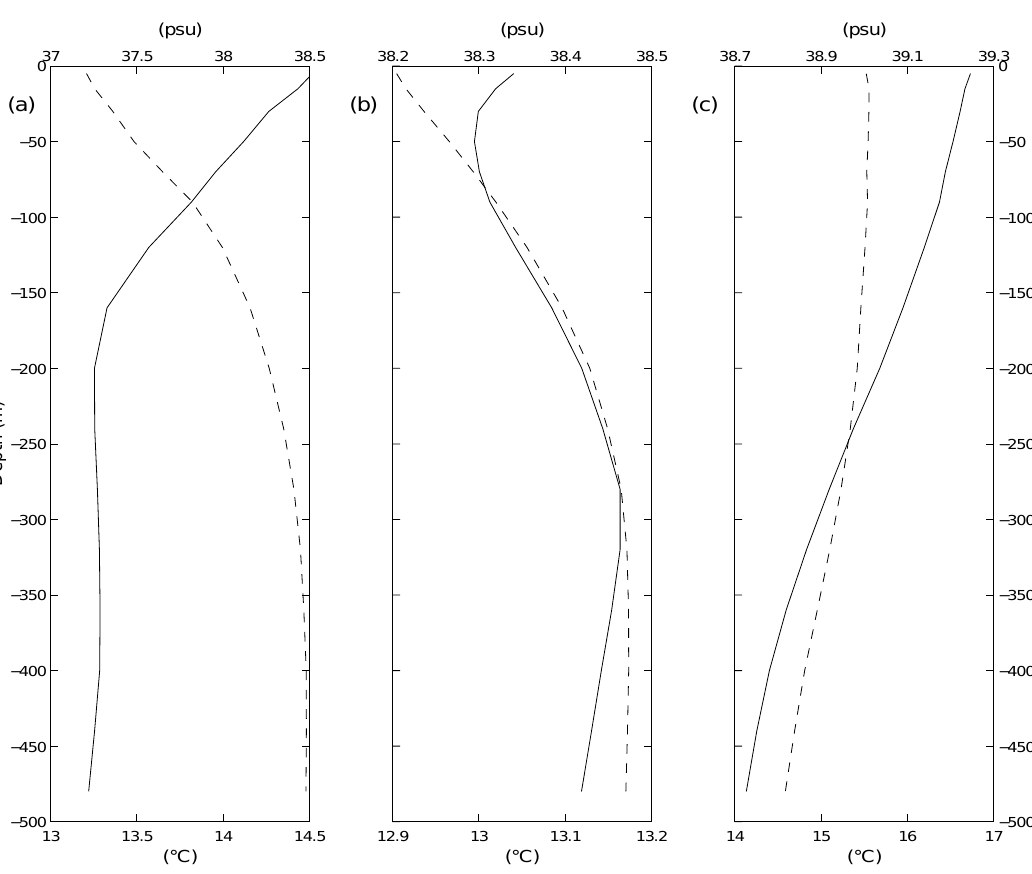
Fig. 5. Mean winter vertical structure of temperature (solid line) and salinity (dashed line) calculated as regional averages for (a) Algerian Basin, (b) northwestern Basin and (c) Levantine